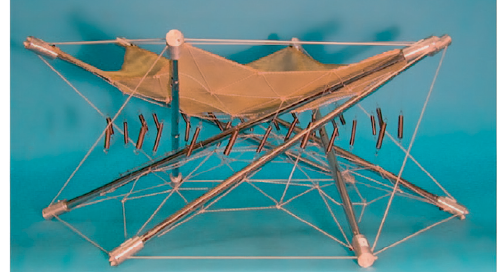
Figure 10. The tensegrity antenna.